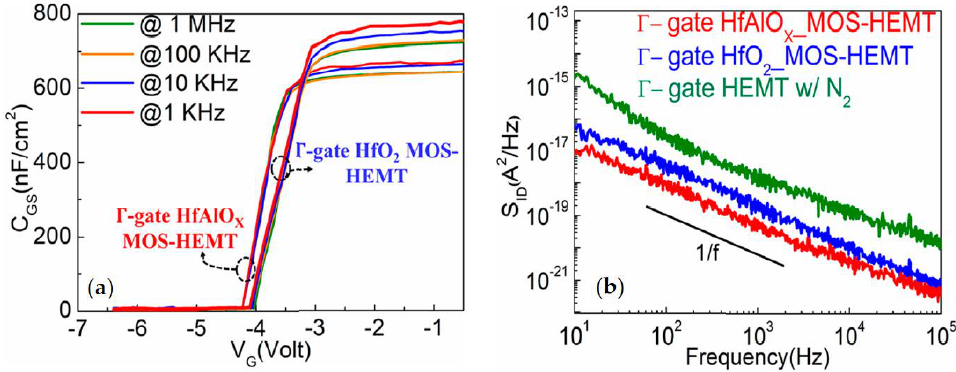
Figure 9. Comparison of ( a ) C-V characteristics of Γ -gate HfO 2 and HfAlO X MOS-HEMT at different frequencies and ( b ) flicker noise characteristics of Γ -gate HEMT, HfO 2 , and HfAlO X MOS-HEMT with the N 2 plasma